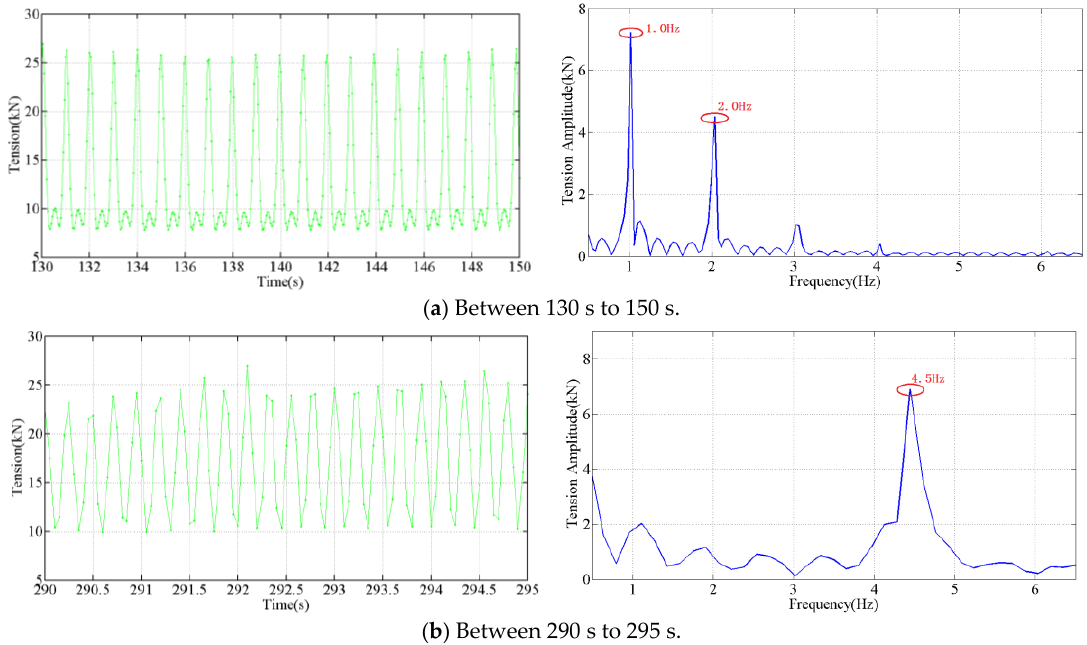
Figure 15. Measured tension and its amplitude spectrum (x-axis limits is 0.5 Hz to 6.5 Hz) during the galloping frequency variation experiment.